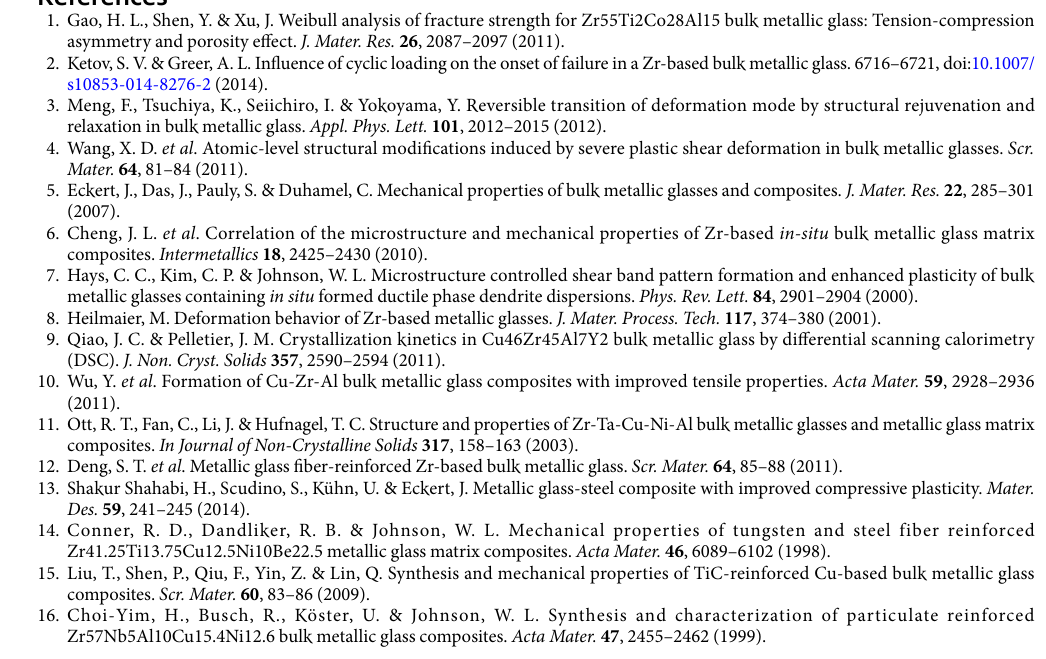
the coin-like HPT samples were cut in half, ground and polished to investigate the cross sections. In SEM the back-scatter detector was used to provide mass contrast so that the two phases are more easily distinguishable. Vickers hardness was measured along the diameter on the cross section with a load of 0.5 kg. An error of 2% for the measured hardness values is assumed and the standard deviation errors of the fitted curve were calculated and used for the error bars for Fig. 5. For nanoindentation testing of the powder and the deformed sample, a platform nanoindenter G200 (Keysight Tec) was used and the experiments were conducted under constant indentation strain rate (0.05 s − 1 ) to a maximum indentation depth of 500 nm. The hardness was measured con- tinuously over indentation depth and was averaged between an indentation depth between 400 to 450 nm. The non-deformed powder was embedded and then mechanical ground and polished like the surface of the deformed sample. Several particles were indented and for both materials, a mean value and the standard deviation were calculated from all indentations. A 5-circle X-ray diffractometer equipped with a source for Cu-K α radiation was used for XRD phase analysis of the specimens. Half samples were used and the surface was grounded to remove any impurities from the HPT process. The investigated 2-Theta range was concentrated around the first amor- phous peak (the strongest).